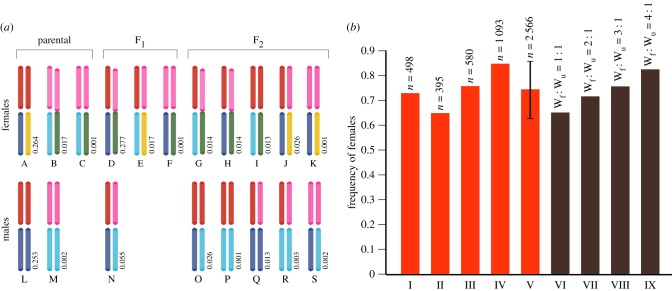
(a) The array of karyotypes in the F2 from founder crosses between D. c. dorippus and D. c. chrysippus populations in the Nairobi hybrid zone, displayed by sex and the generation in which they first appear. F2 karyotype frequencies are calculated on the following assumptions: (1) the sex ratio in the founder crosses is 1 : 1 in dorippus and 90% female in chrysippus, (2) the numbers of dorippus and chrysippus females in the founder population is equal, (3) all females are mated, (4) all male offspring of neo-W females die, and (5) there is neutrality and no migration. The upper pair of chromosomes comprises the C-autosomes, red for dorippus and pink for chrysippus. The lower pair shows the Z chromosomes of dorippus (dark blue) and chrysippus (light blue); the yellow W chromosome is always unfused (Wu) in dorippus, whereas in chrysippus the W chromosome shown in green may be unfused or fused to the C-autosome (neo-W).